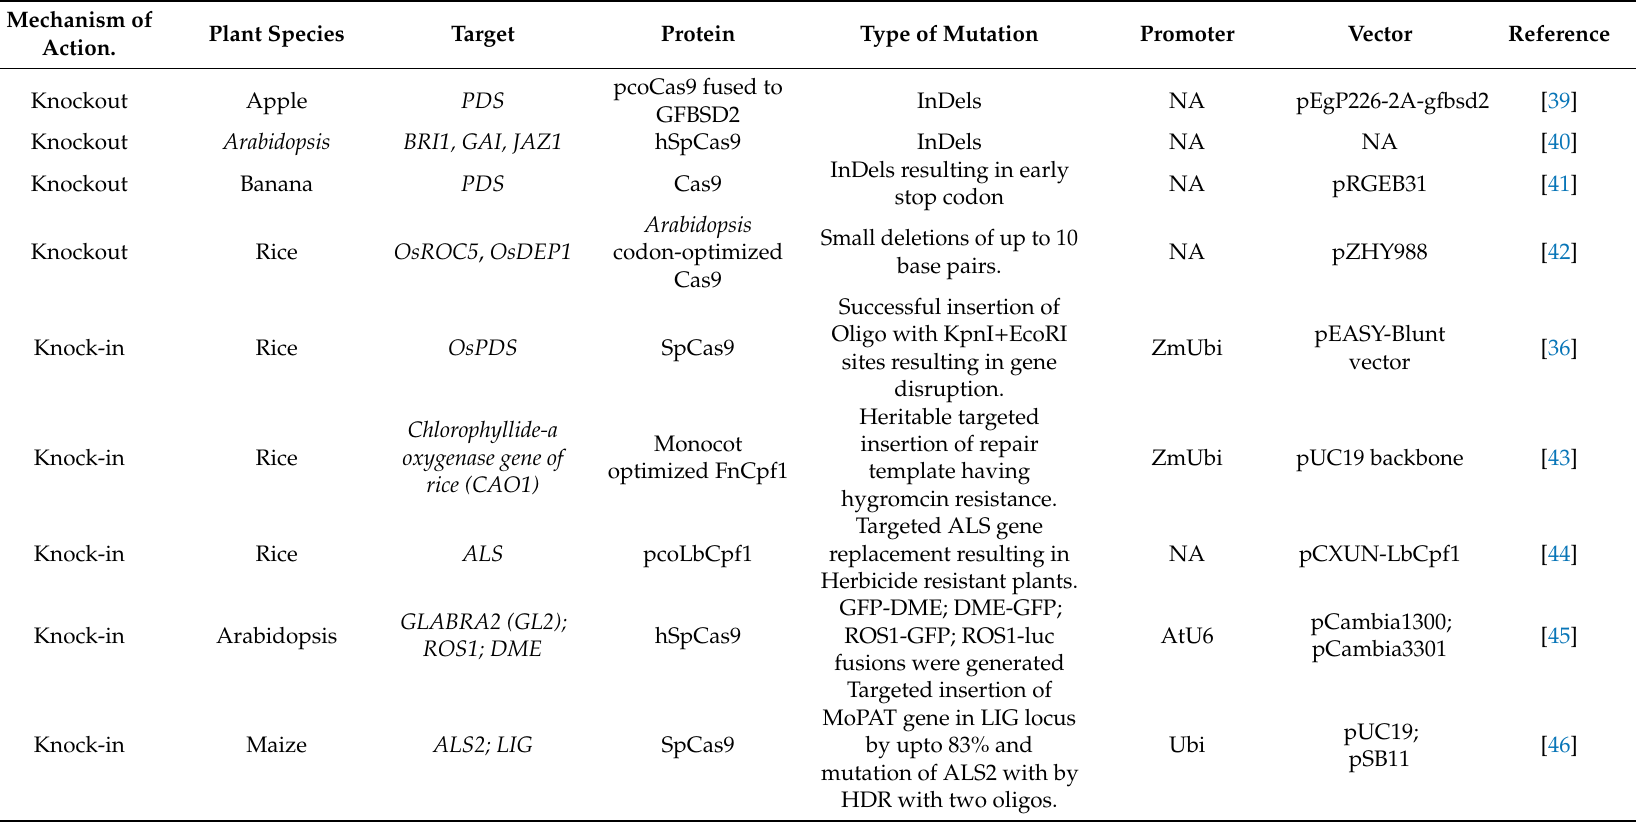
Table 1. Significant studies demonstrating versatile use of genome editing approaches in